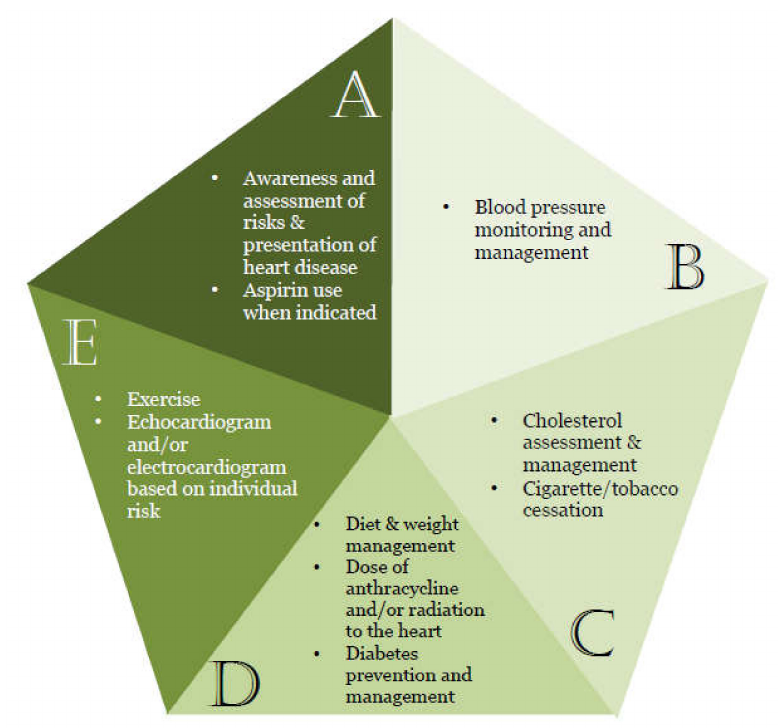
Figure 1. ABCDEs to promote Cardiovascular Health in Cancer